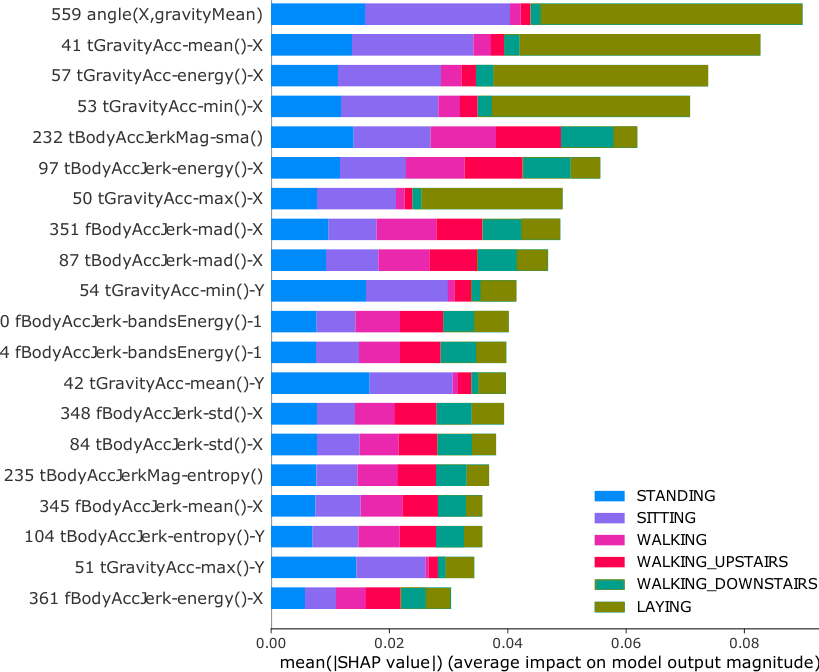
Figure 8. Summary plot for SHAP analysis using cross-validation on UCI dataset. It shows the mean absolute SHAP value of 20 most important features for six